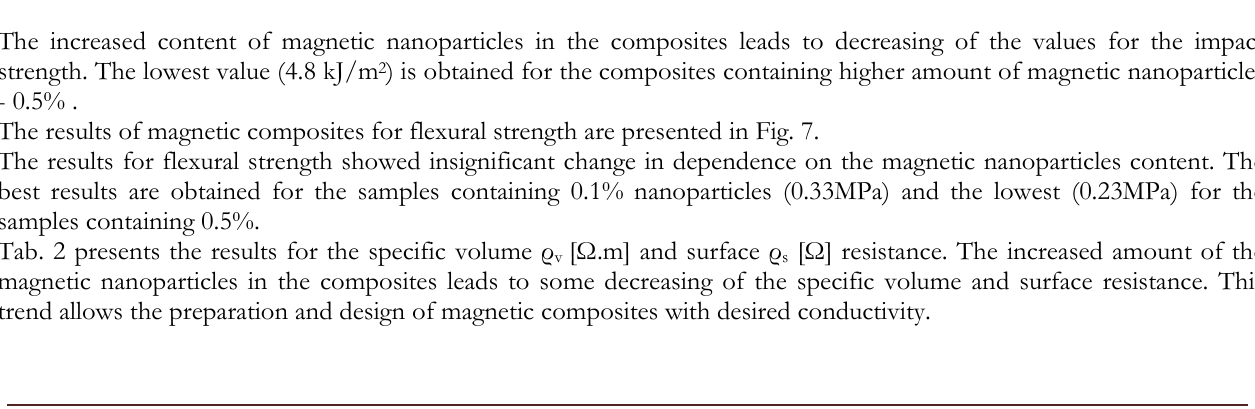
The increased content of magnetic nanoparticles in the composites leads to decreasing of the values for the impact strength. The lowest value (4.8 kJ/m 2 ) is obtained for the composites containing higher amount of magnetic nanoparticles - 0.5%